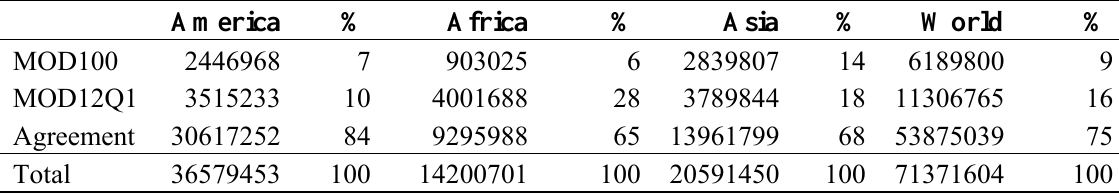
Table 5. A summary of spatial comparison between MOD100 and MOD12Q1 datasets at the scale of continent and the entire tropical zone (30 ° N - 30 °